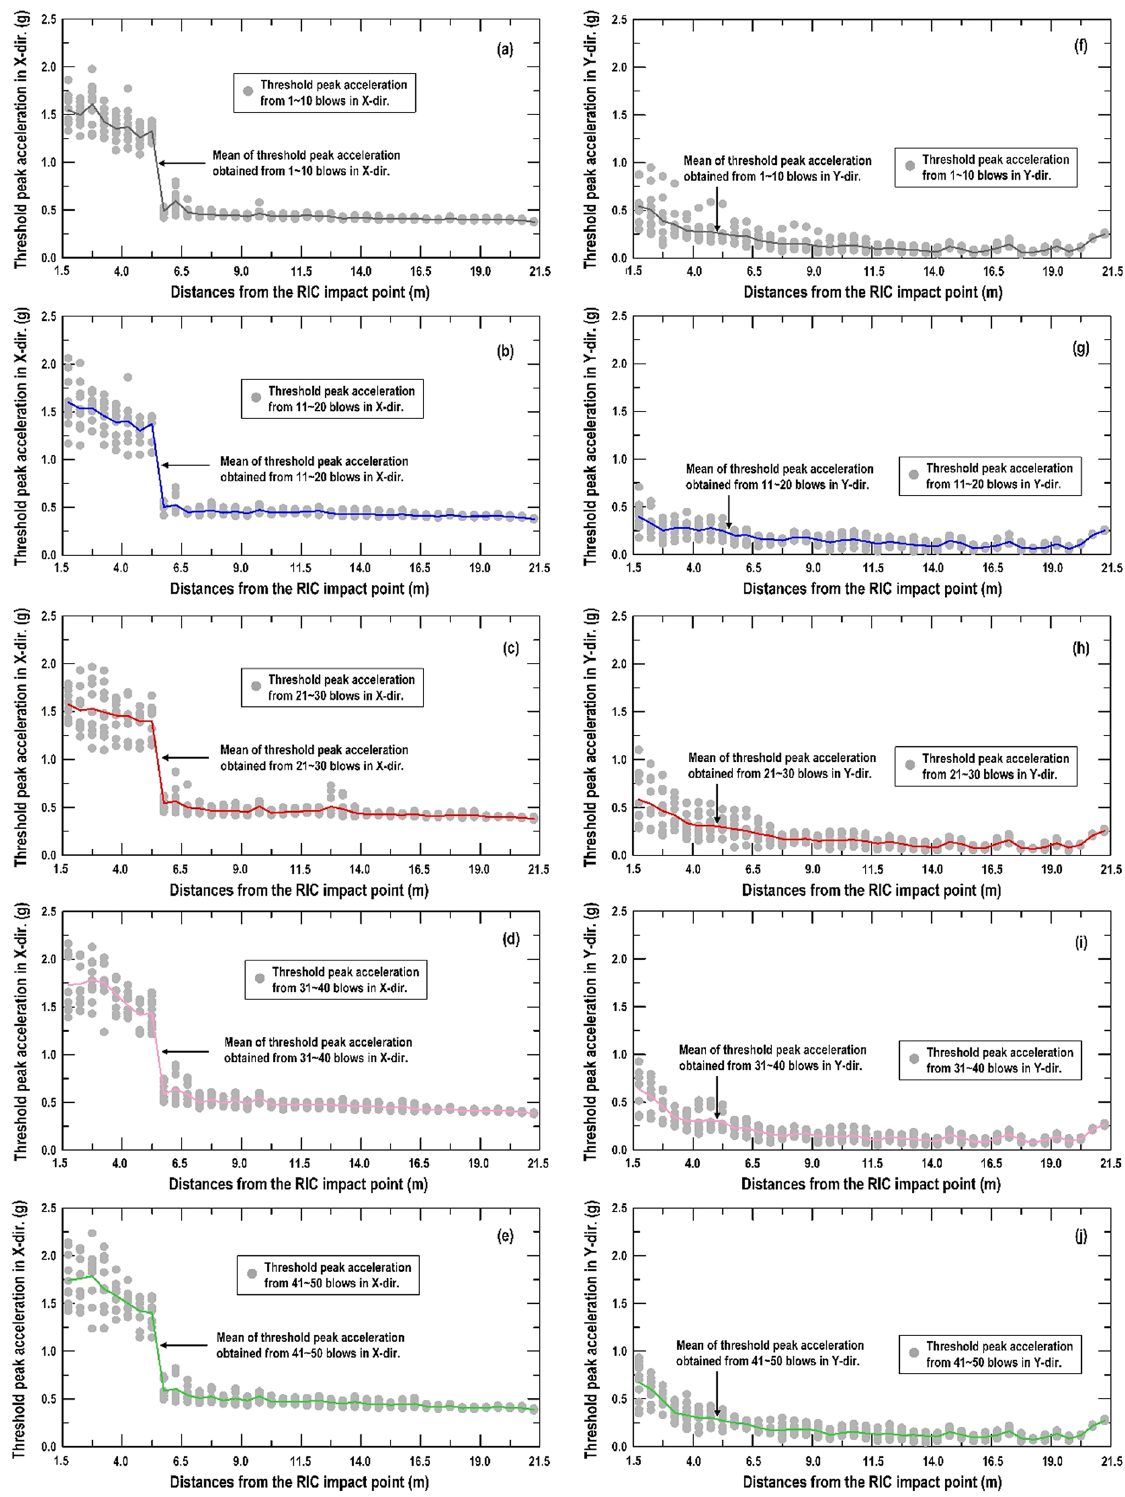
Figure 13. Distributions of the threshold peak acceleration, mean, and standard deviation from the horizontally embedded SAA string during RIC compaction at impact points 1–8: ( a – e ) X-direction response during 1–10, 11–20, 21–30, 31–40, and 41–50 blows; ( f – j ) Y-direction response during 1–10, 11–20, 21–30, 31–40, and 41–50